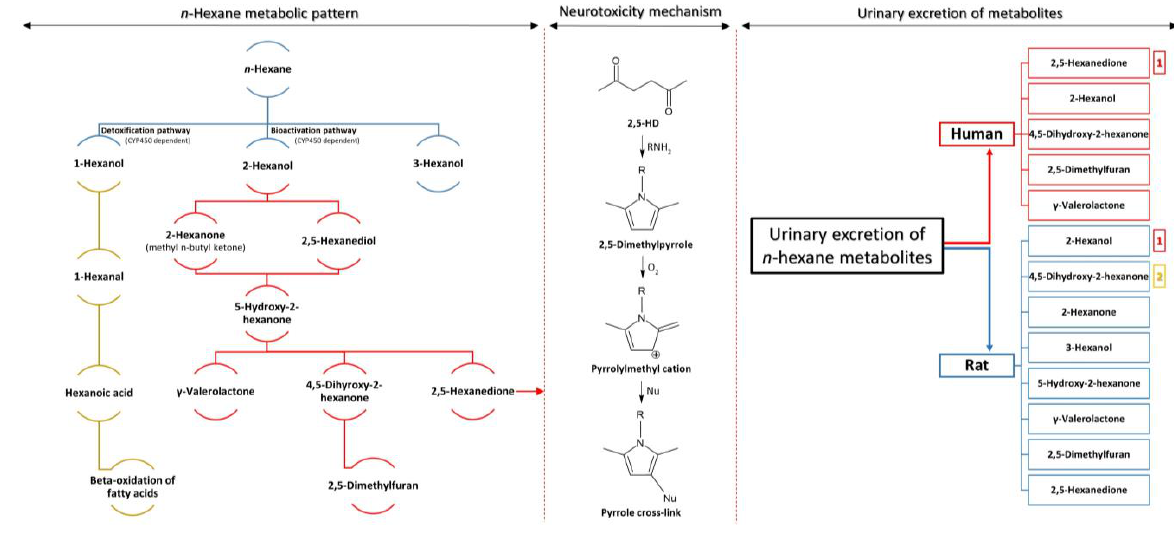
Figure 3. n -Hexane metabolic pattern, neurotoxicity mechanism, and metabolites urinary